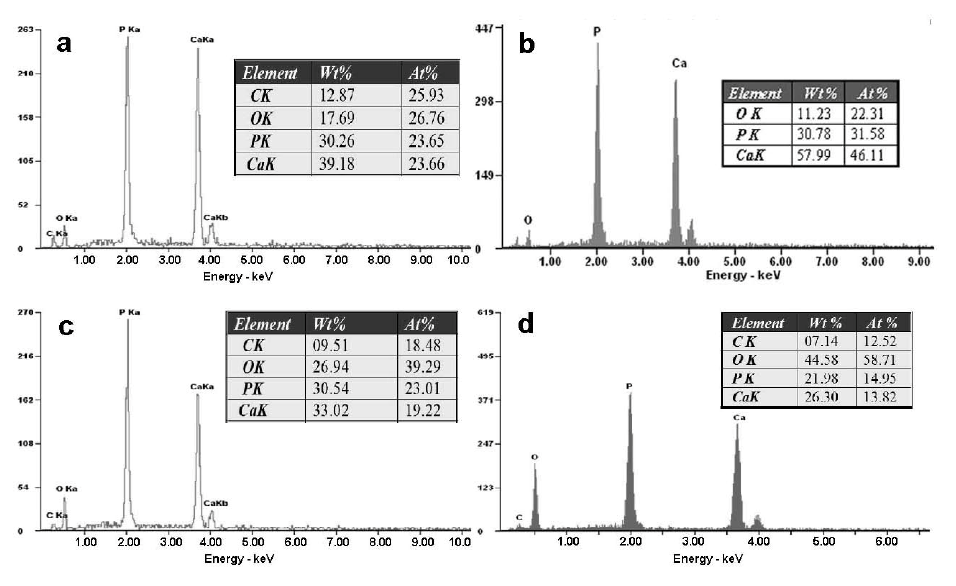
Figure 3. Energy dispersive spectroscopy (EDS) for the different morphologies in the DCPD coating and the HA coating: ( a ) and ( b ) correspond to Figure 2b and Figure 2c, respectively; ( c ) and ( d ) correspond to Figure 2e and Figure 2f, respectively.